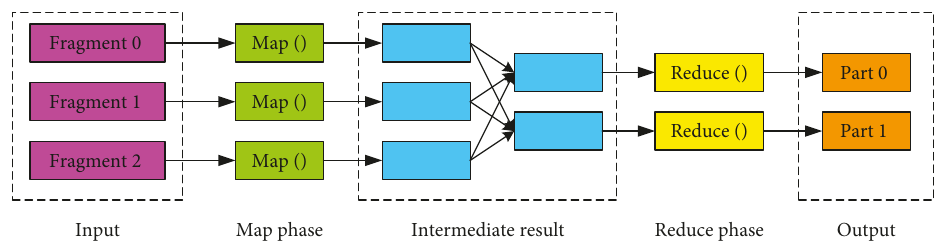
Figure 1: Process fl ow of